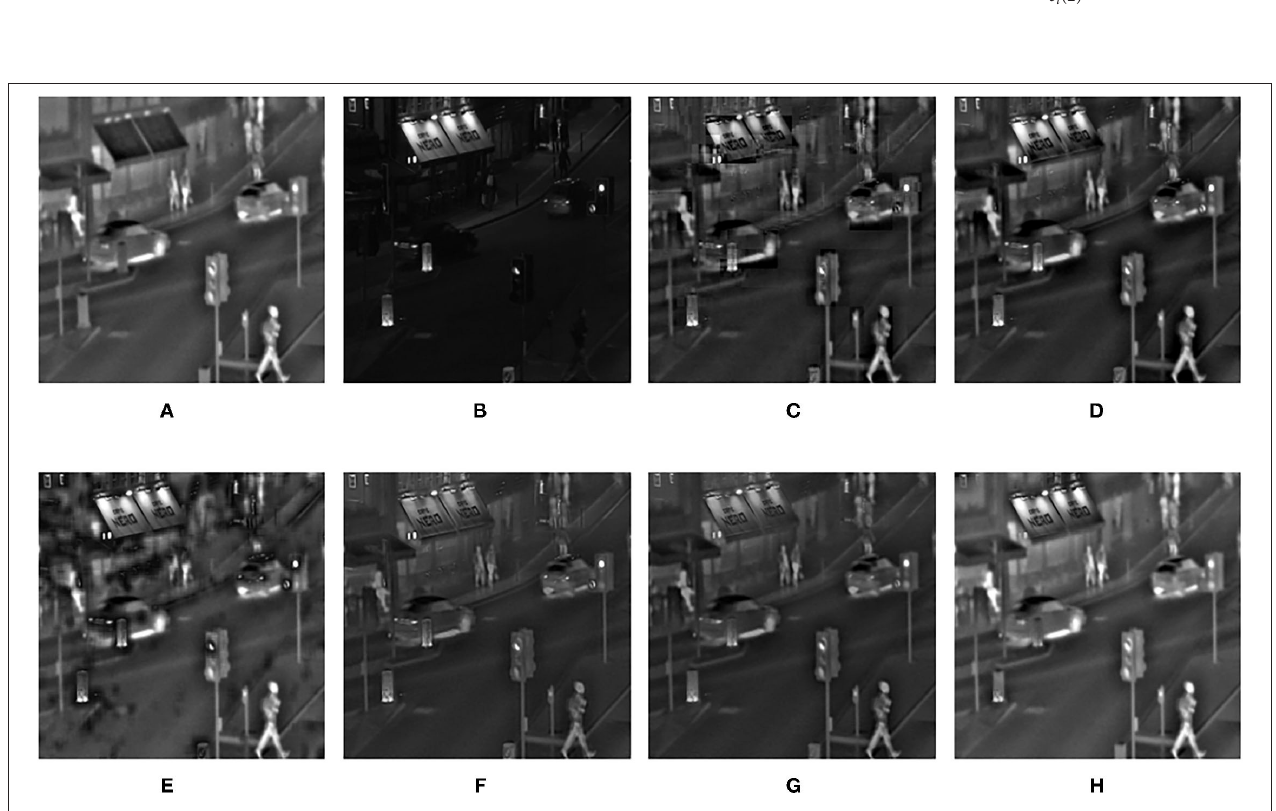
FIGURE 9 | Comparison experimental results of infrared and visible images. (A) original image (infrared image); (B) original image (visible image); (C) DWT; (D) LP; (E) SR; (F) DTCWT-SR; (G) VGG; (H) MPS.